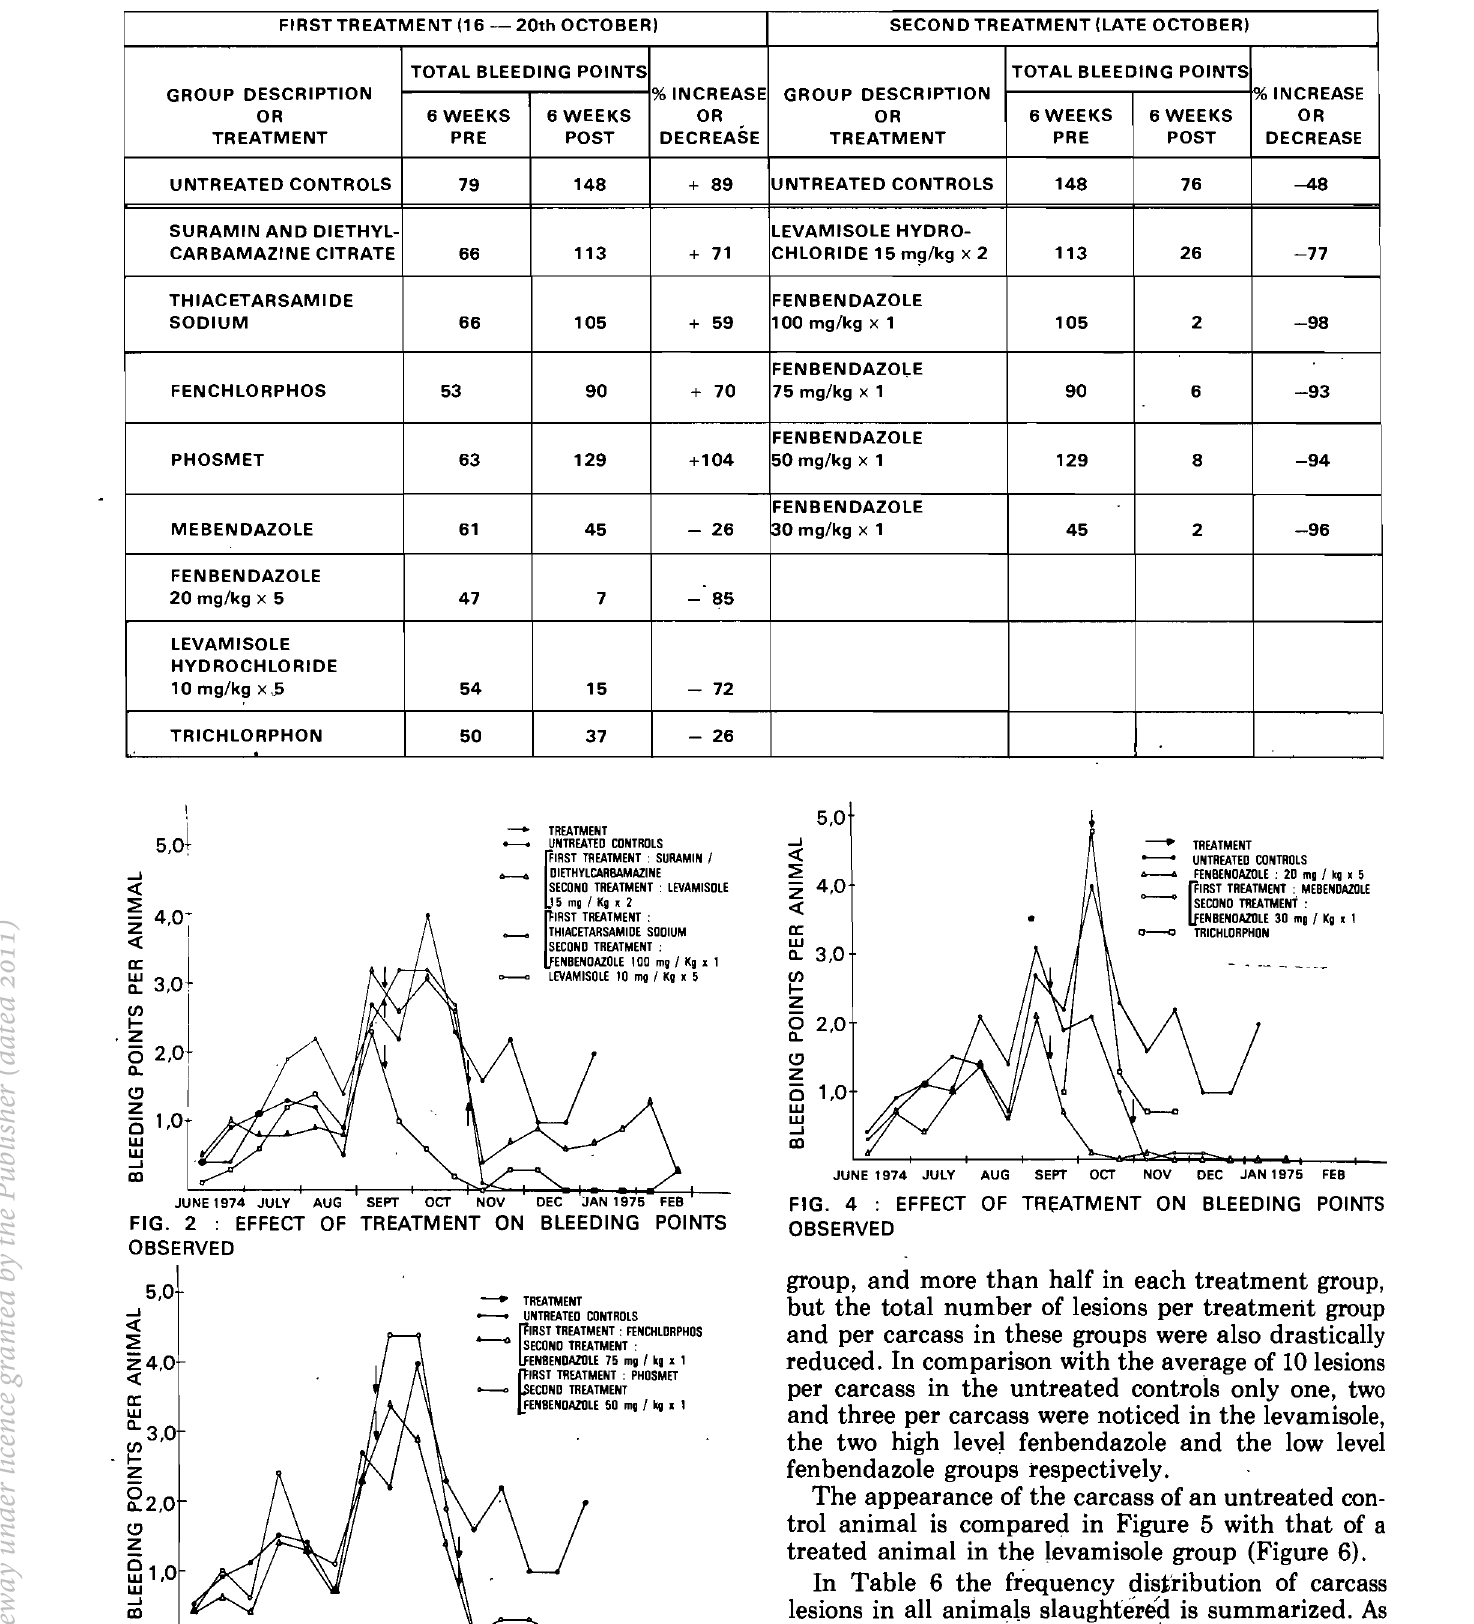
NOV DEC JAN 1975 FEB